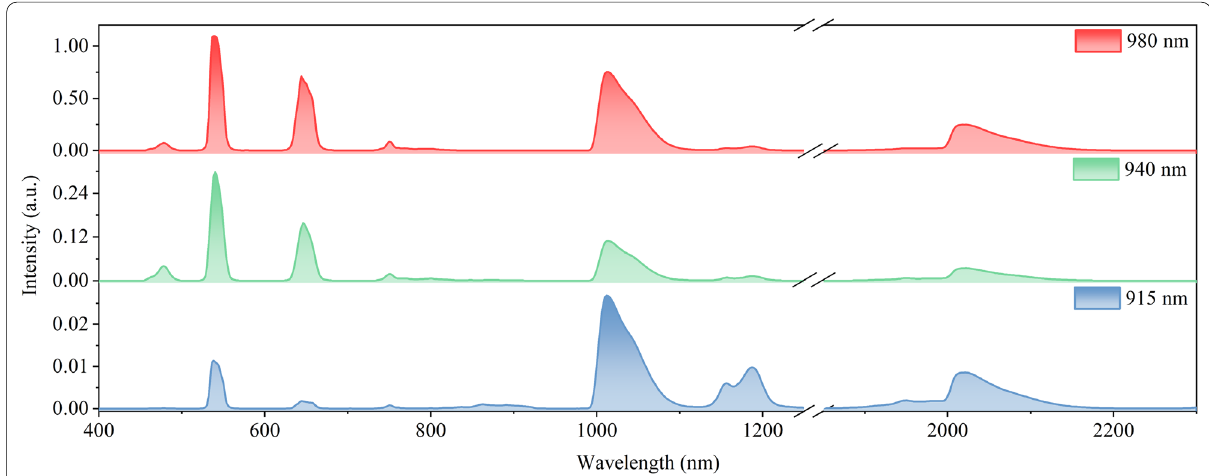
Fig. 4 The spectra of SrF 2 :Yb 3 + /Ho 3 + (12/0.1 mol%) NCs under the 980, 940 and 915 nm excitations,